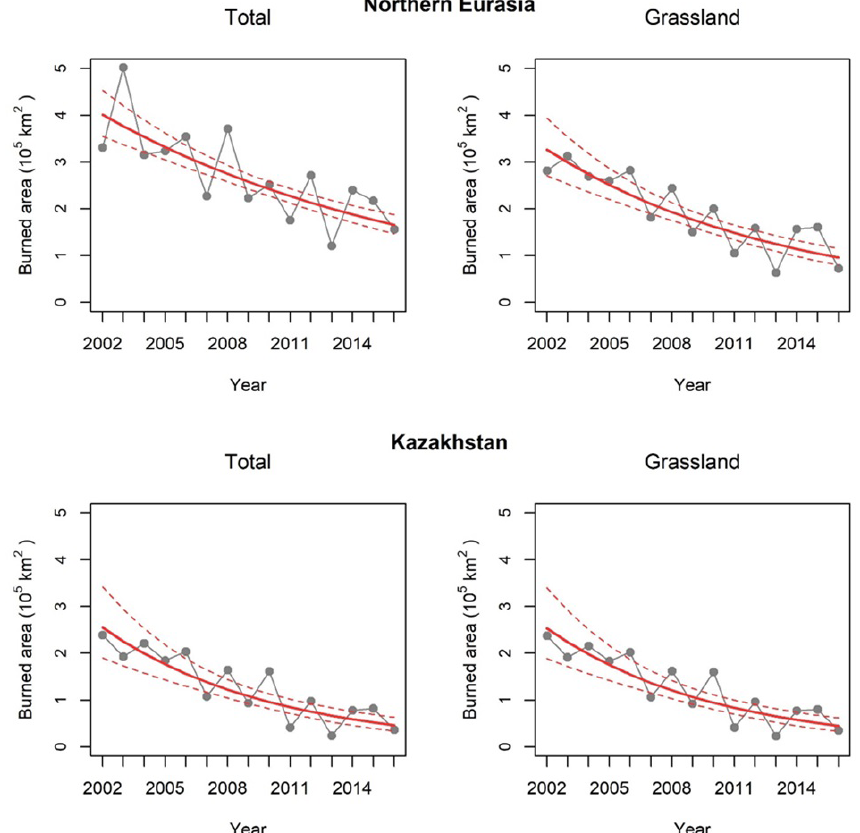
Figure 4. Declining trends in the total area and grassland area burned in northern Eurasia (including Kazakhstan) and Kazakhstan from 2002 to 2016. The solid lines are the trend lines, and the dotted lines are 95% confidence